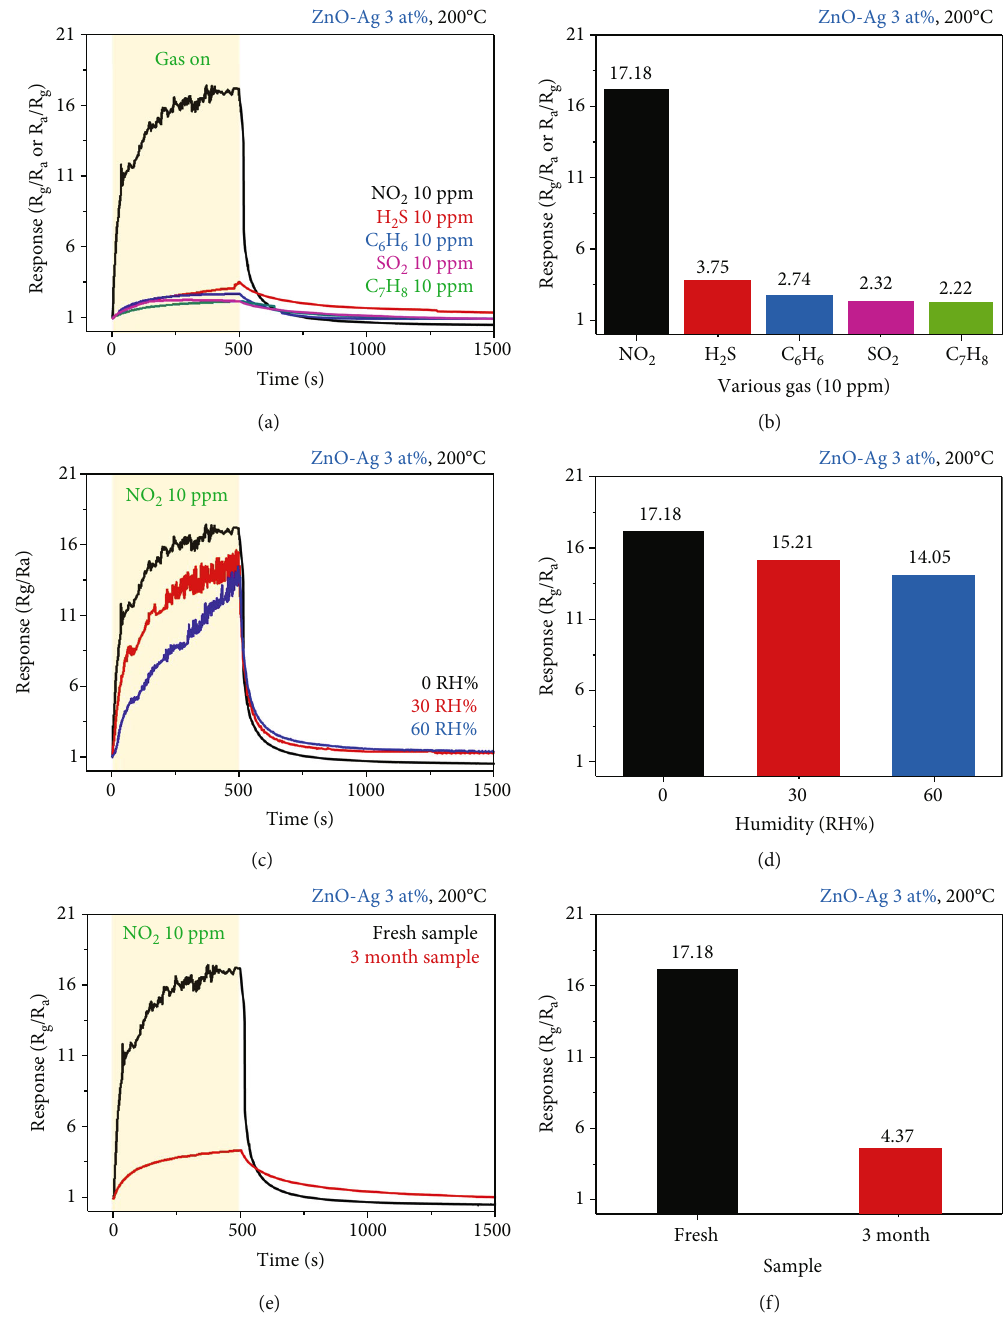
Figure 9: (a) Dynamic response curves of the 3 at% Ag-functionalized porous ZnO sheet gas sensor to 10 ppm of various gases at 200 ° C. (b) Selectivity pattern of (a, c). Dynamic resistance curve of the 3 at% Ag-functionalized porous ZnO sheet gas sensor in the presence of 30% RH and 60% RH. (d) Response comparison of 10 ppm NO gas sensor in dry and humid atmospheres. (e) Dynamic response curve of the 3 at% 2 Ag-functionalized porous ZnO sheet gas sensor after three months. (f) Comparison between the response of the gas sensor to 10ppm NO in a fresh state and after three